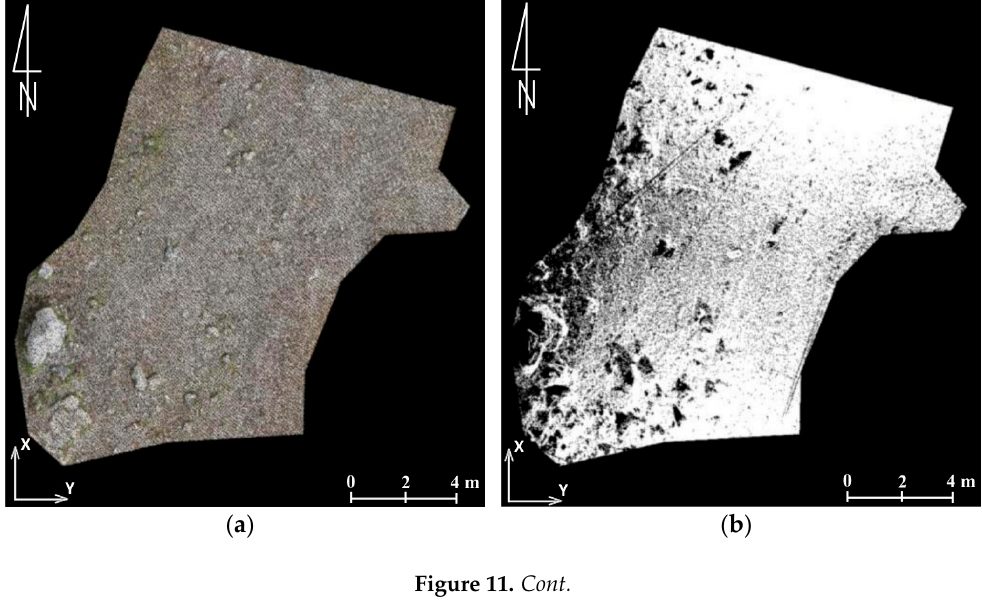
Figure 10. Results of comparing the point cloud from TLS with the point cloud from the UAV ( a ) and mesh model from the UAV ( b ) for the first test field (source: authors’ own study) (the units given in m).